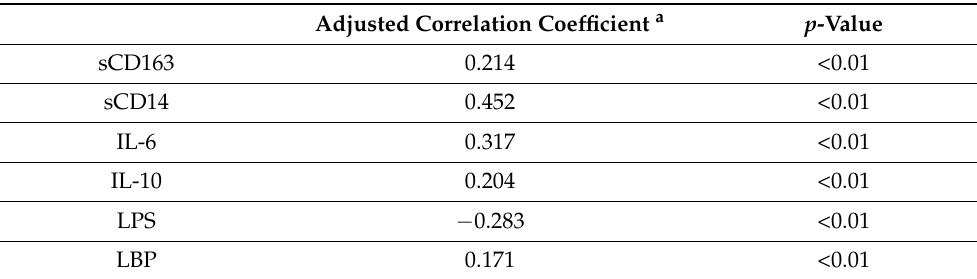
Table 3. Adjusted correlations between plasma marker levels and FIB-4 values.